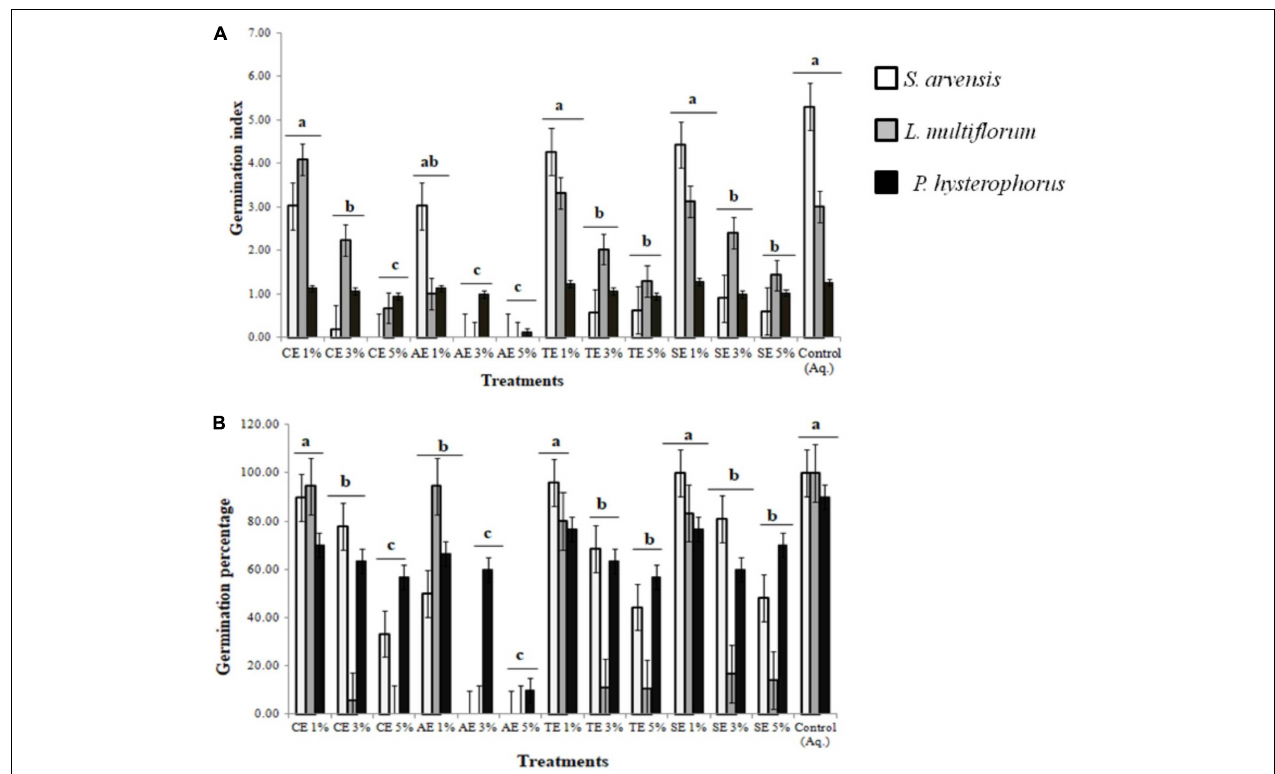
FIGURE 1 | Effect of methanolic extracts of castor (CE), artemisia (AE), wheat (TE), and sorghum (SE) on (A) germination index (GI) and (B) germination percentage (G%) of Sinapis arvensis , Lolium multiflorum , and Parthenium hysterophorus. Data are presented as mean ± SEM ( n = 30). Bar values with different letters differ significantly at P < 0.05. One percent of all extracts did not show any significant inhibition against weeds, whereas 3 and 5% AE along with 5% of all the other extracts significantly reduced GI and G%, whereby inducing 40–100% germination inhibition in all weeds.